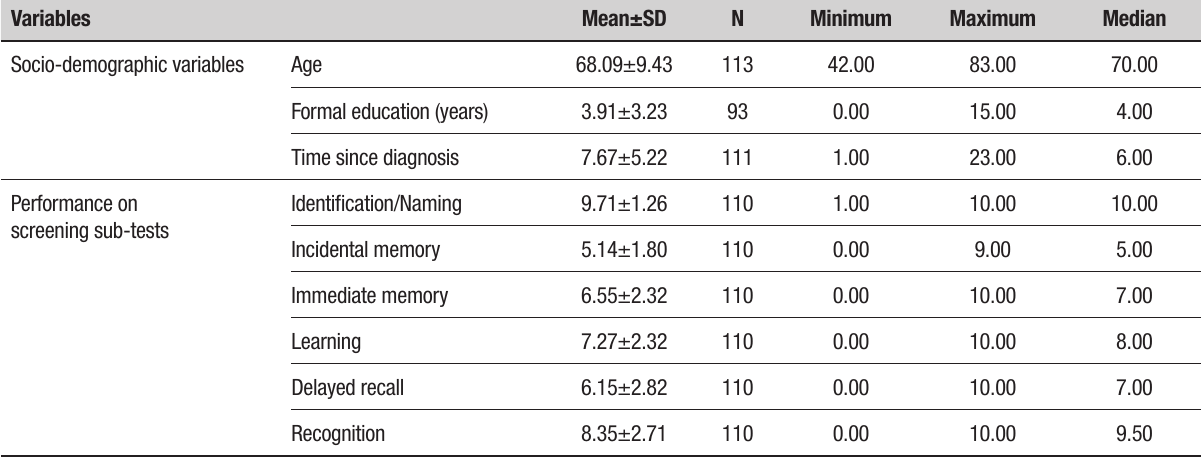
Table 1. Descriptive measures of socio-demographic variables and performance on sub-tests.